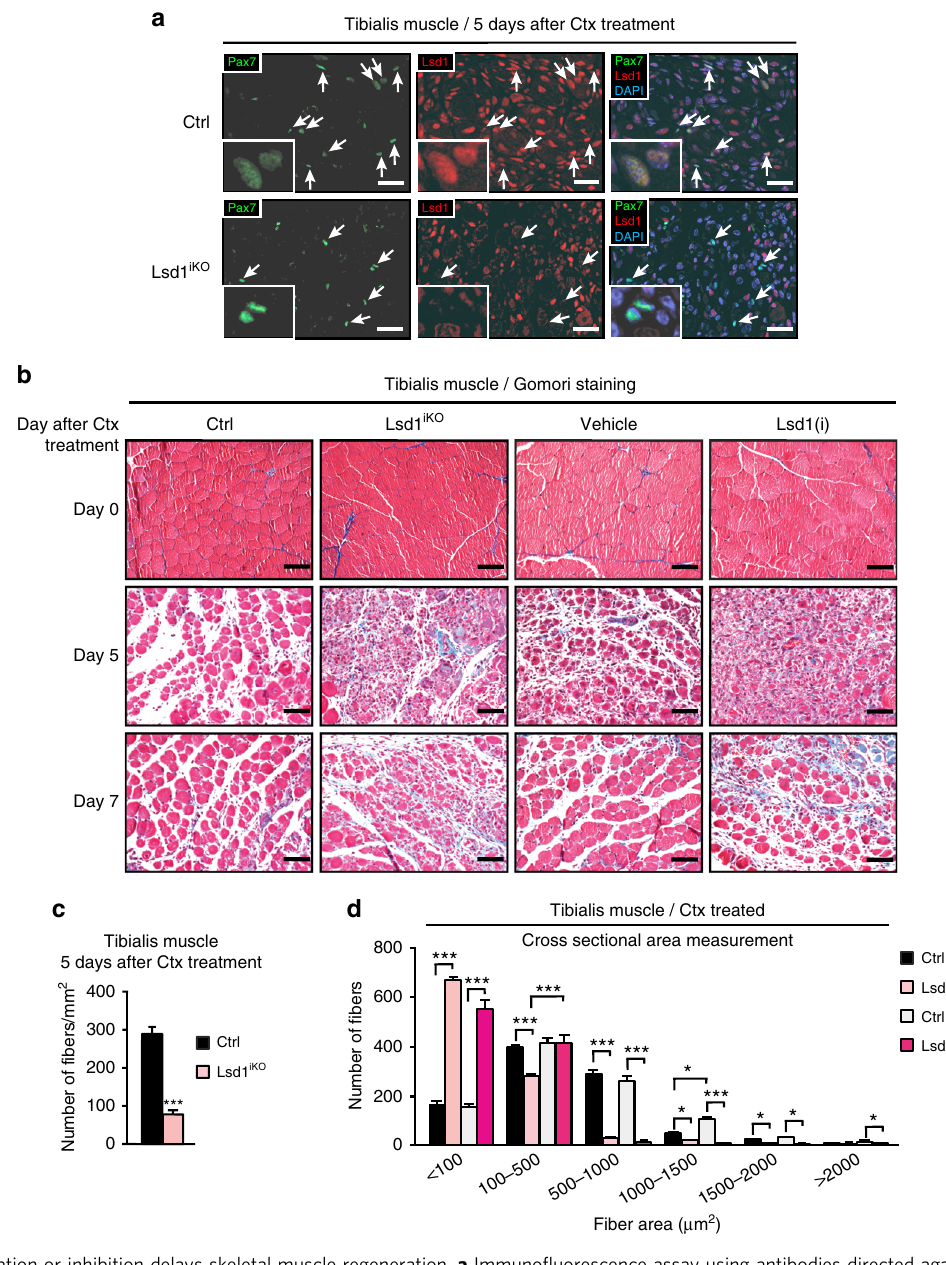
Fig. 1 Lsd1 ablation or inhibition delays skeletal muscle regeneration. a Immuno fl uorescence assay using antibodies directed against paired box 7 (Pax7, green) and lysine-speci fi c demethylase 1 (Lsd1, red) on tibialis muscle sections of control mice (Ctrl) or mice with selective Lsd1 ablation in Pax7-positive satellite cells (Lsd1 iKO ) 5 days after cardiotoxin (Ctx) treatment. Nuclei were stained with DAPI (blue). Arrows indicate that Lsd1 is expressed in Pax7- positive satellite cells of control mice, whereas it is ablated from Lsd1 iKO Pax7-positive satellite cells. b Gomori staining of representative tibialis muscle sections from Ctrl, Lsd1 iKO mice, and wild-type mice treated with vehicle or Lsd1 inhibitor [Lsd1(i)], 0, 5, and 7 days after cardiotoxin (Ctx) injection. c , d Analyses of regenerating centronuclear fi bers in Ctrl and Lsd1 iKO mice 5 or 7 days after Ctx treatment. c Number of fi bers per area (mm 2 ). Signi fi cance was calculated by two-tailed Student ’ s t -test. d Cross-sectional area (CSA) measurement of fi bers. Signi fi cance was calculated by two-way analysis of variance (ANOVA) test. ( c , d : n = 5; mean + SEM, * p < 0.05, ** p < 0.01, *** p < 0.001; scale bars: a 50 µ m, b 100 µ increased numbers of fi bers with a surface area 100 – 500 of μ m 2 To con fi rm that an increased differentiation capacity of satellite (Fig. 2c). At day 7 post treatment, fi bers with larger surface area cells is responsible for faster muscle regeneration in vivo, we ( > 1000 μ m 2 ) prevailed in LSD1 cTg mice, indicating faster isolated satellite cells from myo fi bers of wild-type extensor regeneration (Fig. 2c). Of note, morphology and fi ber size digitorum longus (EDL) muscle 32 , overexpressed LSD1 by adenoviral infection, and differentiated them in myogenic medium distribution of untreated tibialis muscle from LSD1 cTg mice was for 0, 1, 3, or 7 days. Constructs used for adenoviral infection not different from that of their control littermates (Ctrl) additionally harbored a GFP cassette, allowing us to trace (Supplementary Fig. 2b, c). Together, our data indicate that transduced cells. LSD1 overexpressing satellite cells (LSD1-GFP) higher Lsd1 levels in myoblast precursors accelerate muscle had higher differentiation capacity than control cells (Ctrl-GFP), regeneration upon injury.